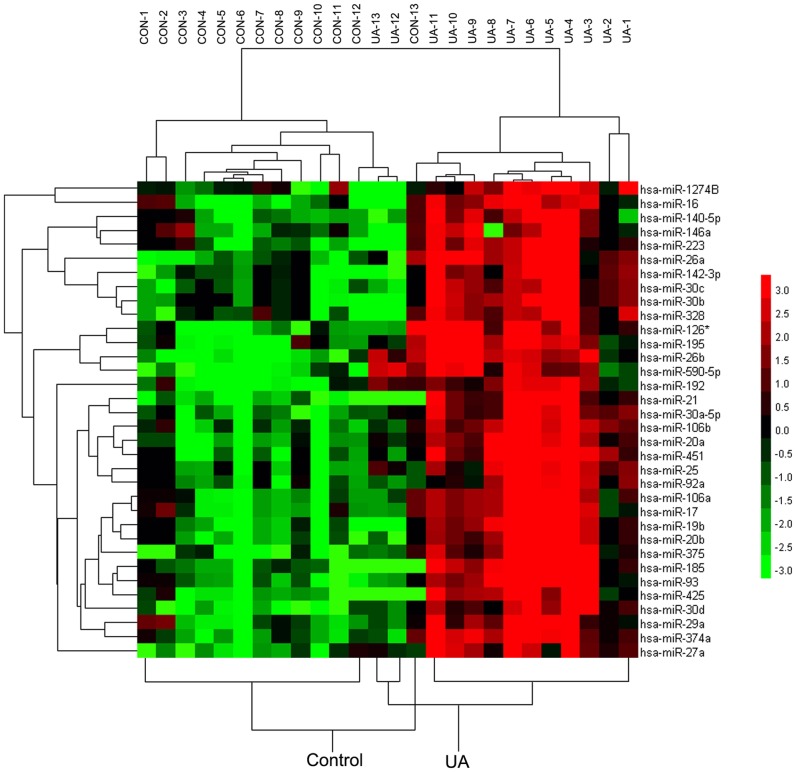
Profile of circulating miRNAs in UA patients (n = 13) and controls (n = 13).Heat map illustrates the levels of significantly changed miRNAs (fold change >8 and FDR <0.0001%) in UA patients compared with controls. Color intensity is scaled within each row, such that the highest expression value corresponds to bright red and the lowest to bright green.